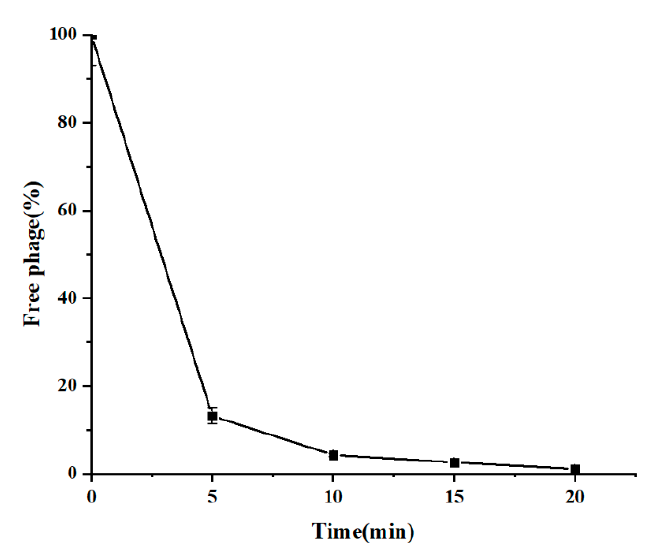
Figure 3. Biological properties of phage BG3P. ( A ) Temperature tolerance in a range from 30 °C to 80 °C. ( B ) pH tolerance after 30 and 60 min of incubation at pH ranging from 2 to 13.Values are the mean of three